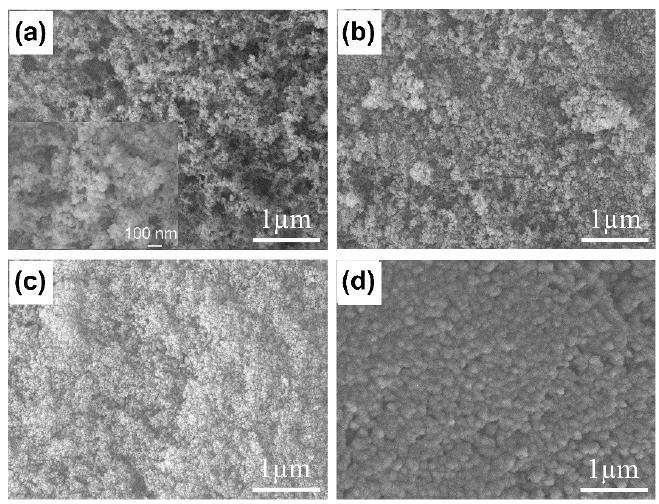
Figure 2. Scanning electron microscopy (SEM) images of ( a ) fumed silica (FS), and ( b – d ) n-octadecane/FS composites with various n-octadecane mass fractions: ( b ) 60 wt%, ( c ) 70 wt%, and ( d ) 75 wt%.